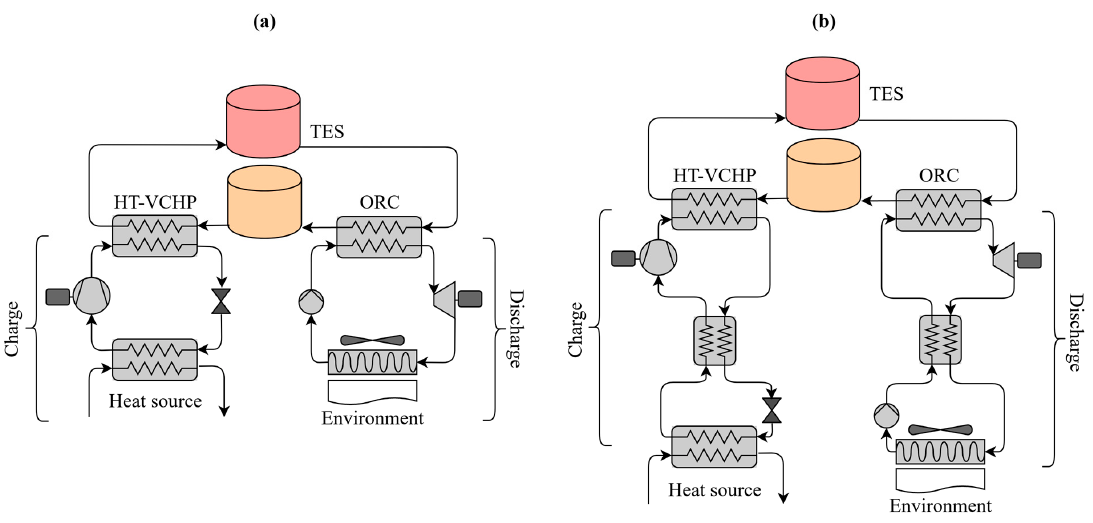
Figure 6. TI-PTES configurations investigated in [22,28] ( a ) and [28,41] ( b ).